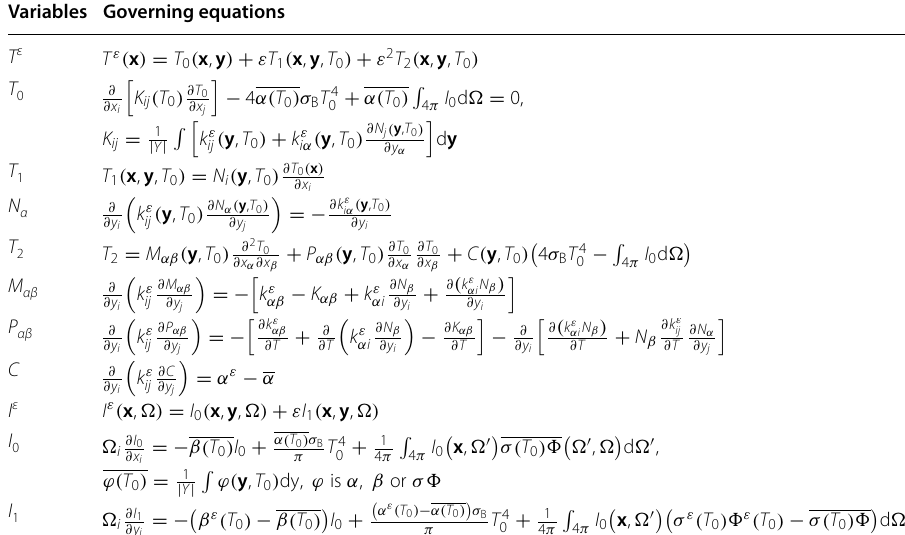
Table 1 The summary of the equations for the homogenization of conduction and radiative transfer